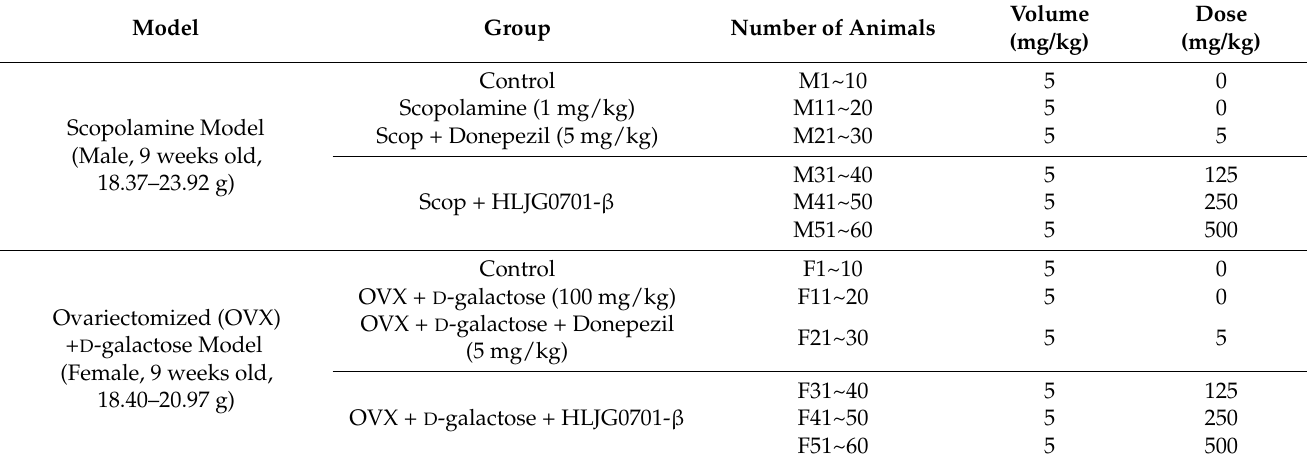
Table 3. The scopolamine-, OVX+ D -galactose-induced mice model study of the test.